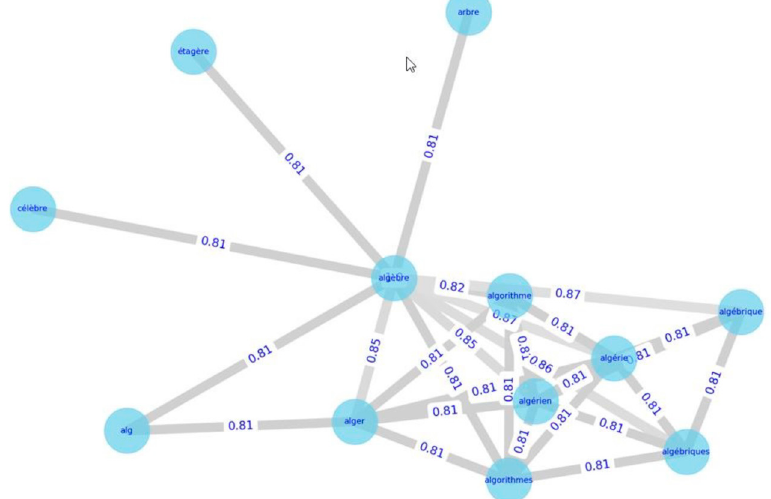
Figure 4. Syntactic similarity graph for “algèbre” .